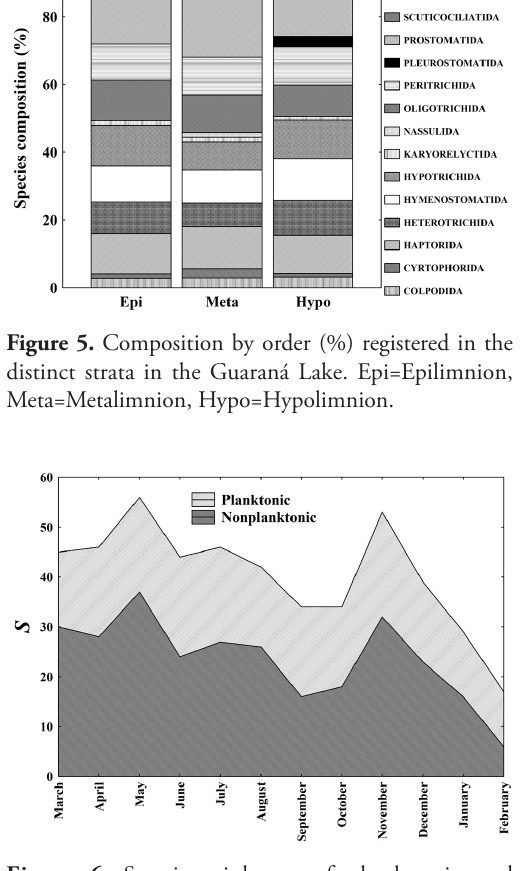
Figure 6. Species richness of planktonic and non-planktonic ciliates, analysed monthly at Guaraná Lake.